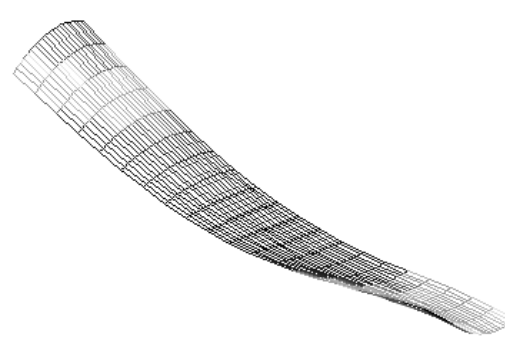
Fig. 9. Measured (curve-fitted) two-dimensional amplitude of vibra- tion